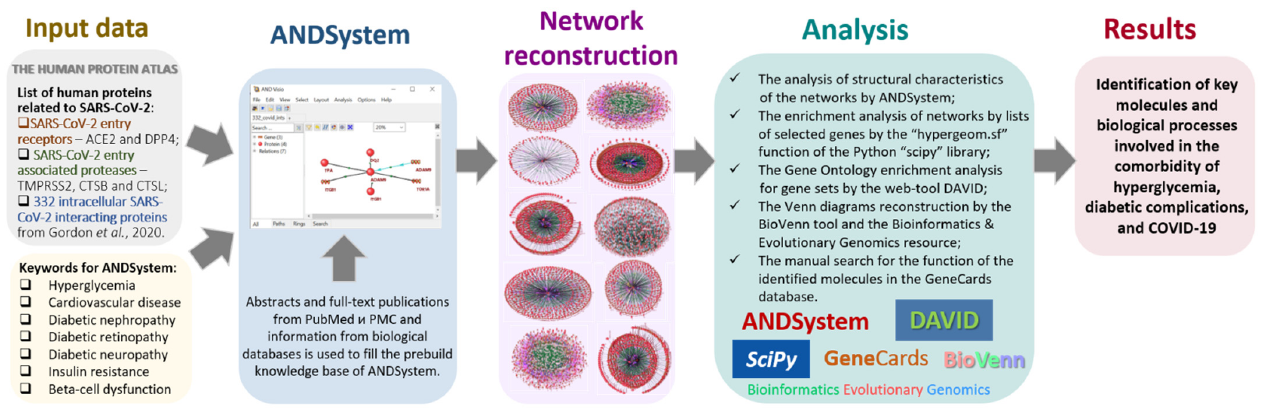
Figure 13. Flowchart of the